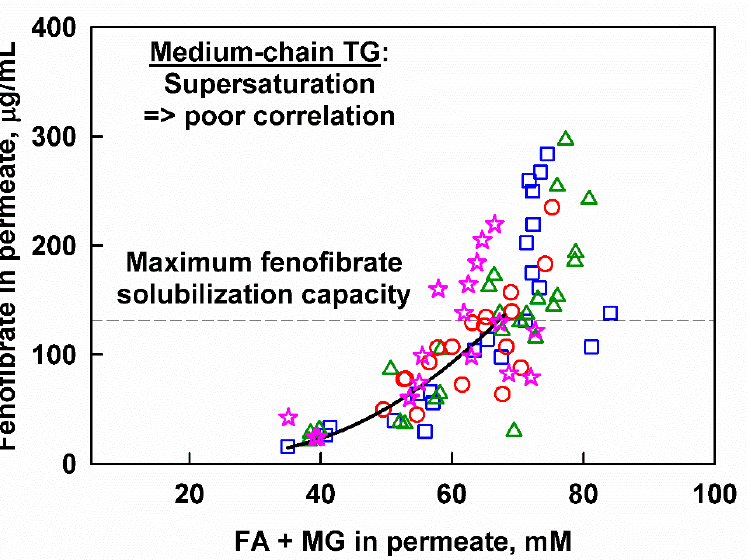
Figure 10. Aqueous fenofibrate as a function of the sum of fatty acids (FA) and monoglycerides (MG) measured in the aqueous phase after in vitro digestion of MCT emulsions with d 43 = 0.4 µm (10 wt% emulsifier, red circles), d 43 = 1.9 µm (1 wt% emulsifier, blue squares), d 43 = 9.3 µm (10 wt% emulsifier, pink stars) and d 43 = 13.9 µm (1 wt% emulsifier green triangles).